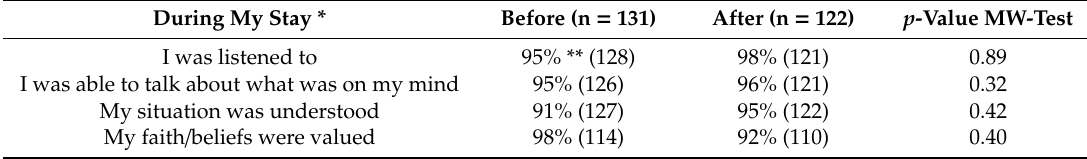
Table 3. Patient reported outcome measure of spiritual care (PROMS)